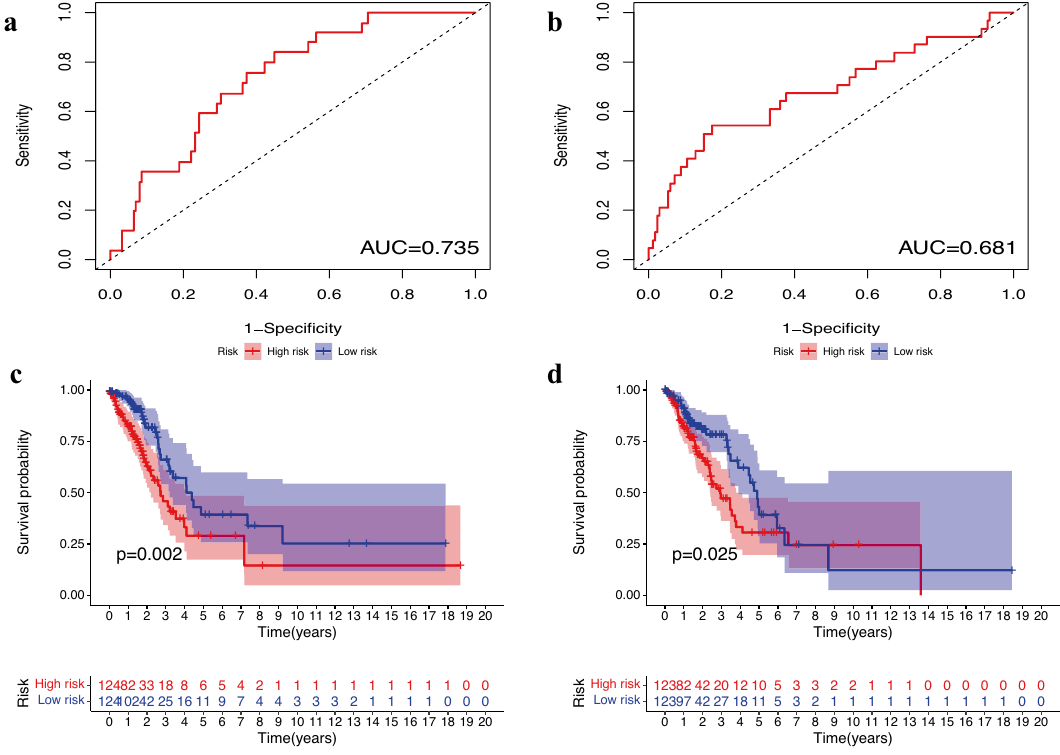
Figure 2. Evaluation of prognostic ability of the model based on clinical information. ( a ) One-year ROC curve in the training set. ( b ) One-year ROC curves in the test set. ( c ) Analysis of survival differences between the distinct risk populations in the training set. ( d ) Survival difference analysis between the distinct risk groups in the test